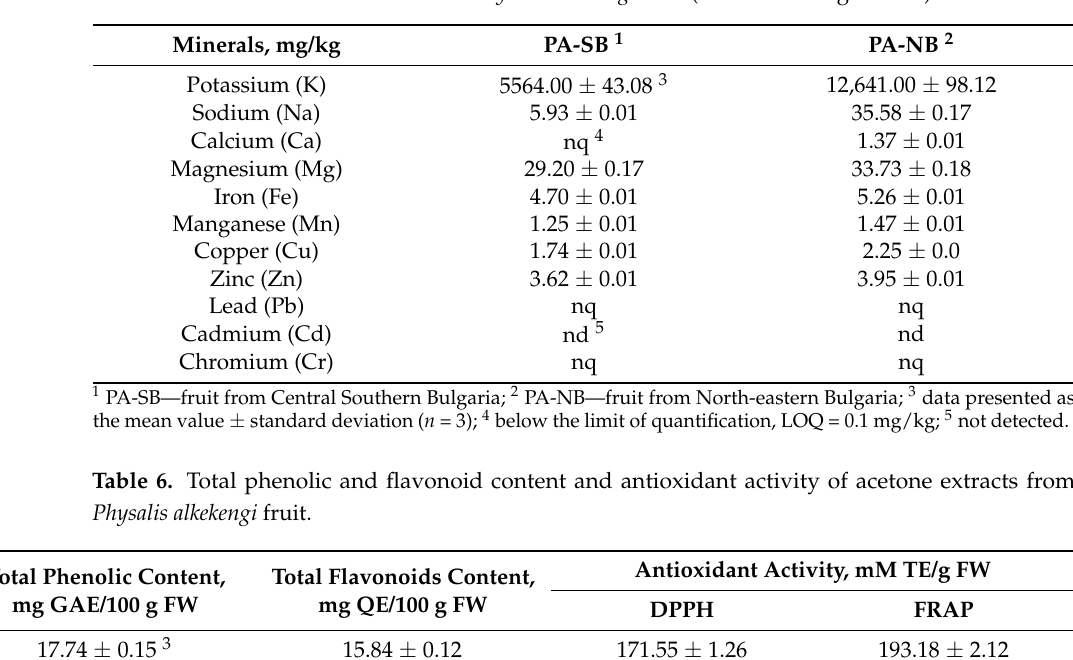
Table 5. Macro- and microminerals in Physalis alkekengi fruit (on a fresh weight basis).